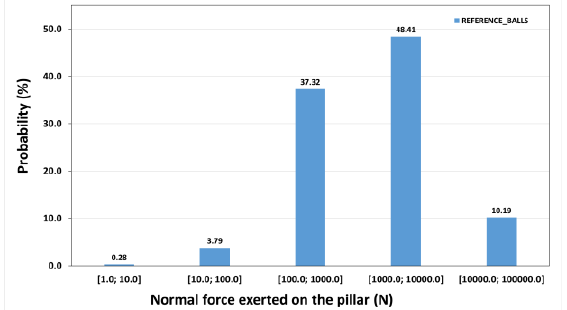
Fig. 5. : Histogram of normal forces for the spherical particles.